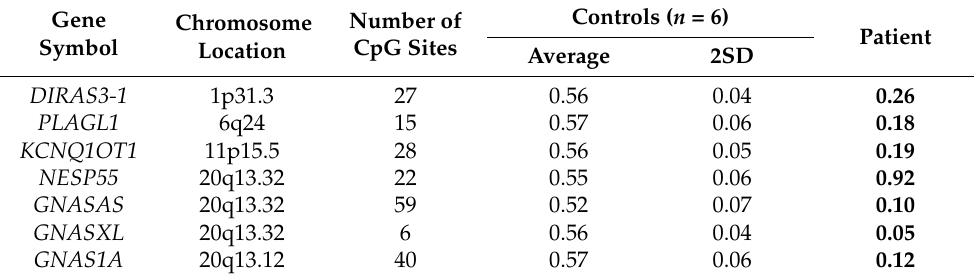
Table 1. Results from detailed analysis of CpG sites overlapping known imprinted loci using 450K methylation